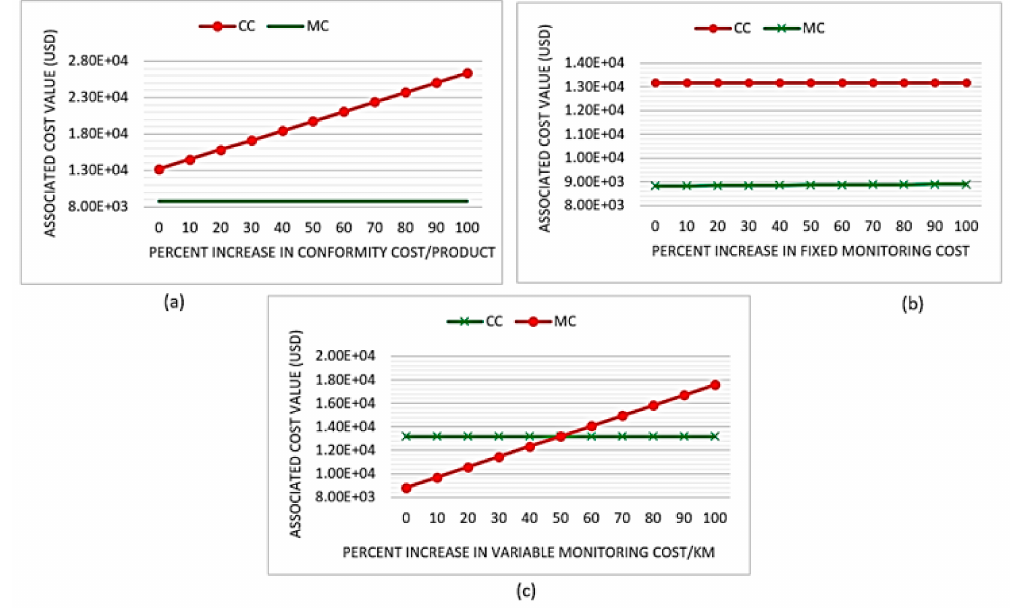
Figure 13. Sensitivity analysis of conformity and monitoring